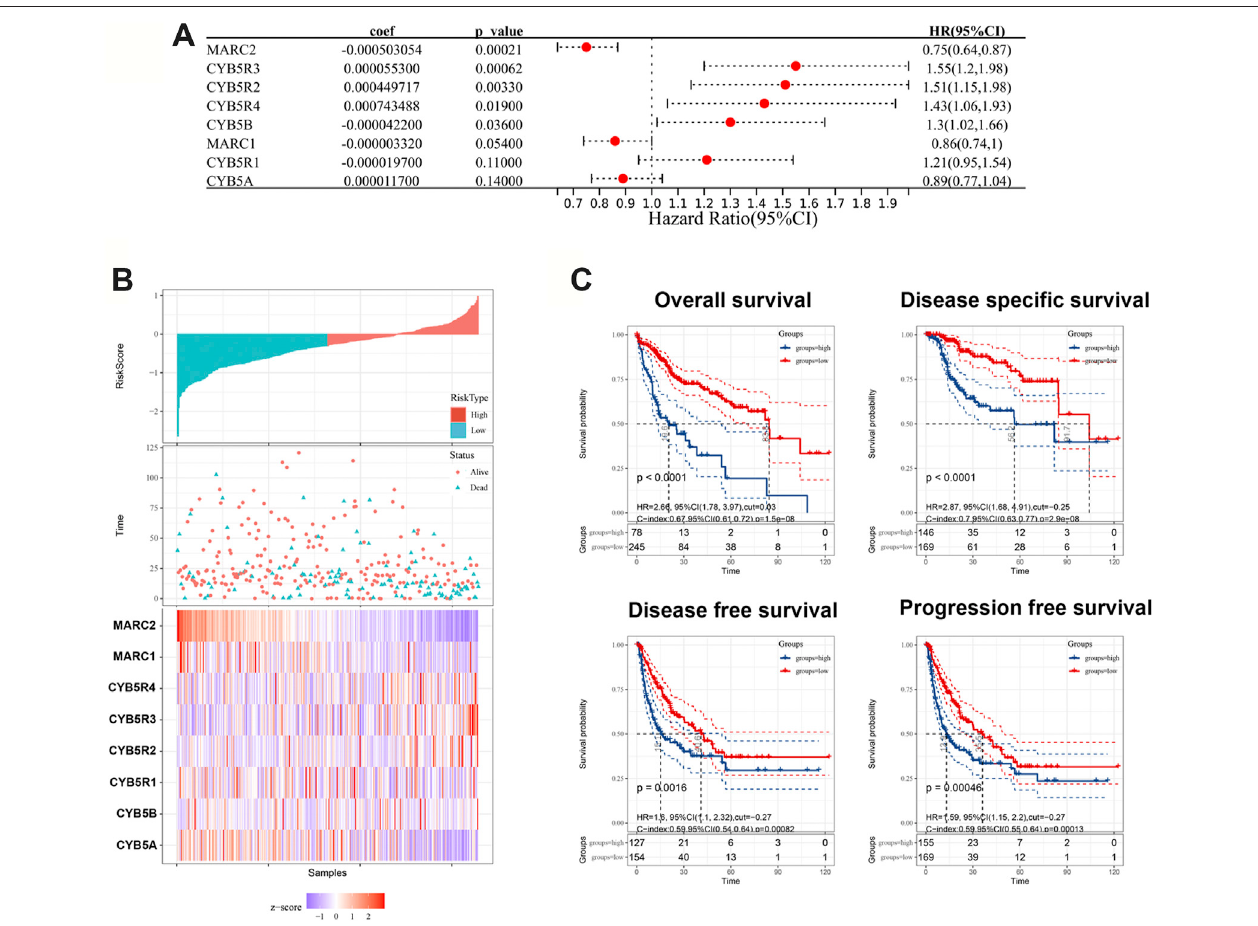
FIGURE 2 | NRES exhibited a prognostic value for HCC. (A) Cox regression analysis was performed by R “ survival ” and “ survminer ” packages to evaluate the relationship between gene expression and OS. (B) The risk scores were created by adding up the product of coef fi cient of each gene and gene expression. (C) The Kaplan-Meier curves for OS, DFS, DFS and PFS; log-rank test was used to compare survival between different groups. The blue curves represented the survival rate of patient with higher level of risk score and the red curves represented the survival rate of patient with lower level of risk score.